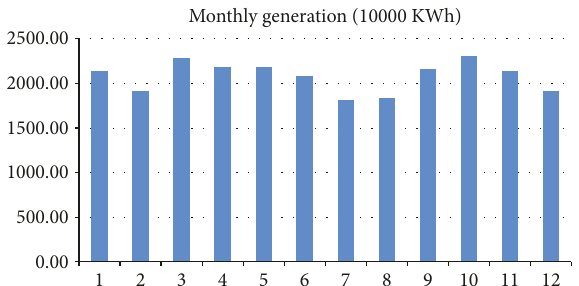
Figure 10: Monthly output production generation.